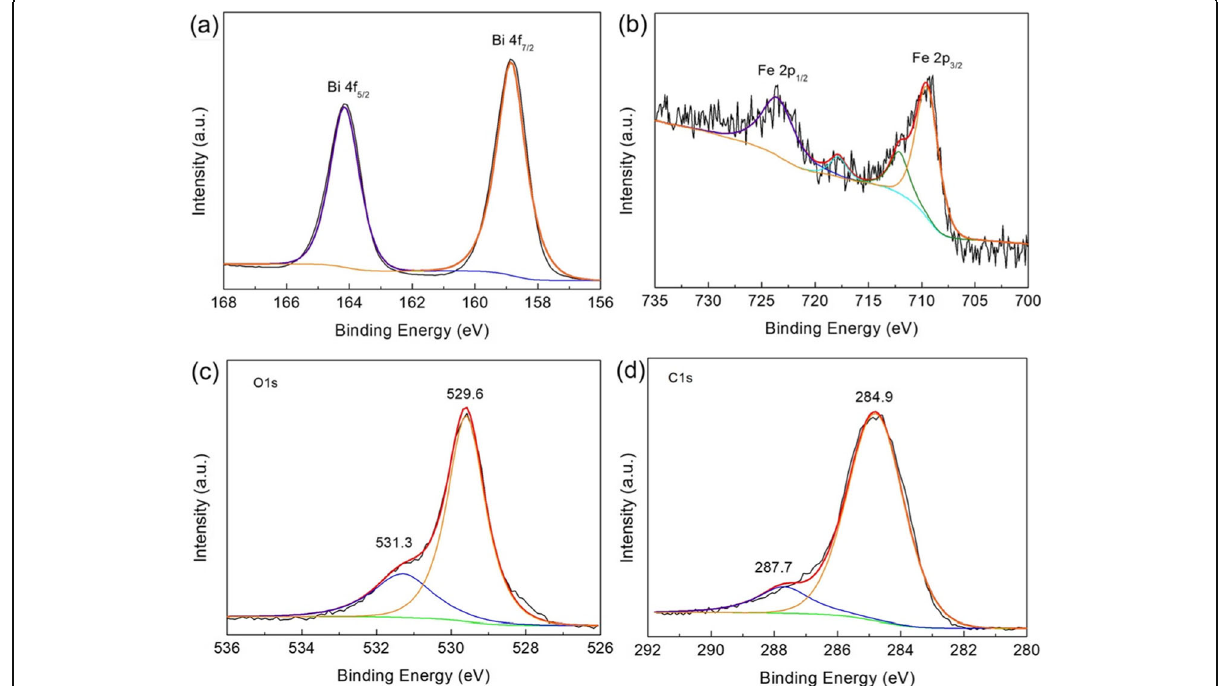
Fig. 5 High-resolution XPS spectra of a Bi 4f, b Fe 2p, c O 1s, and d C 1s for the 12C/BFO